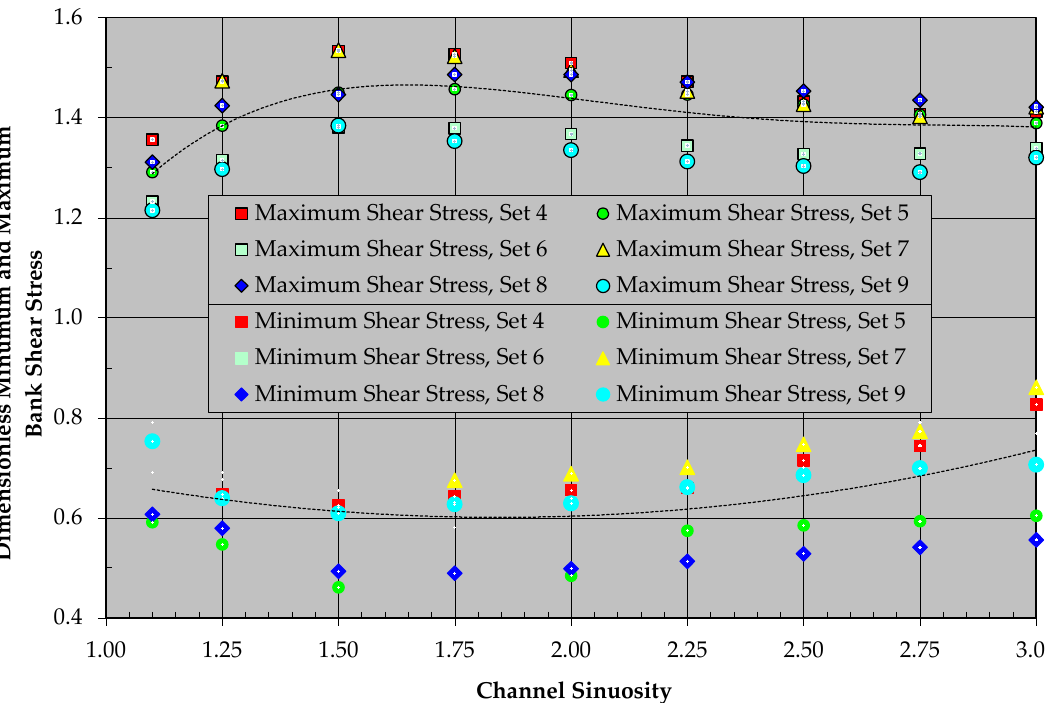
Figure 44. Minimum and maximum shear stresses (along the left and right meandering channel banks for Simulation Sets 4–9) versus channel sinuosity.